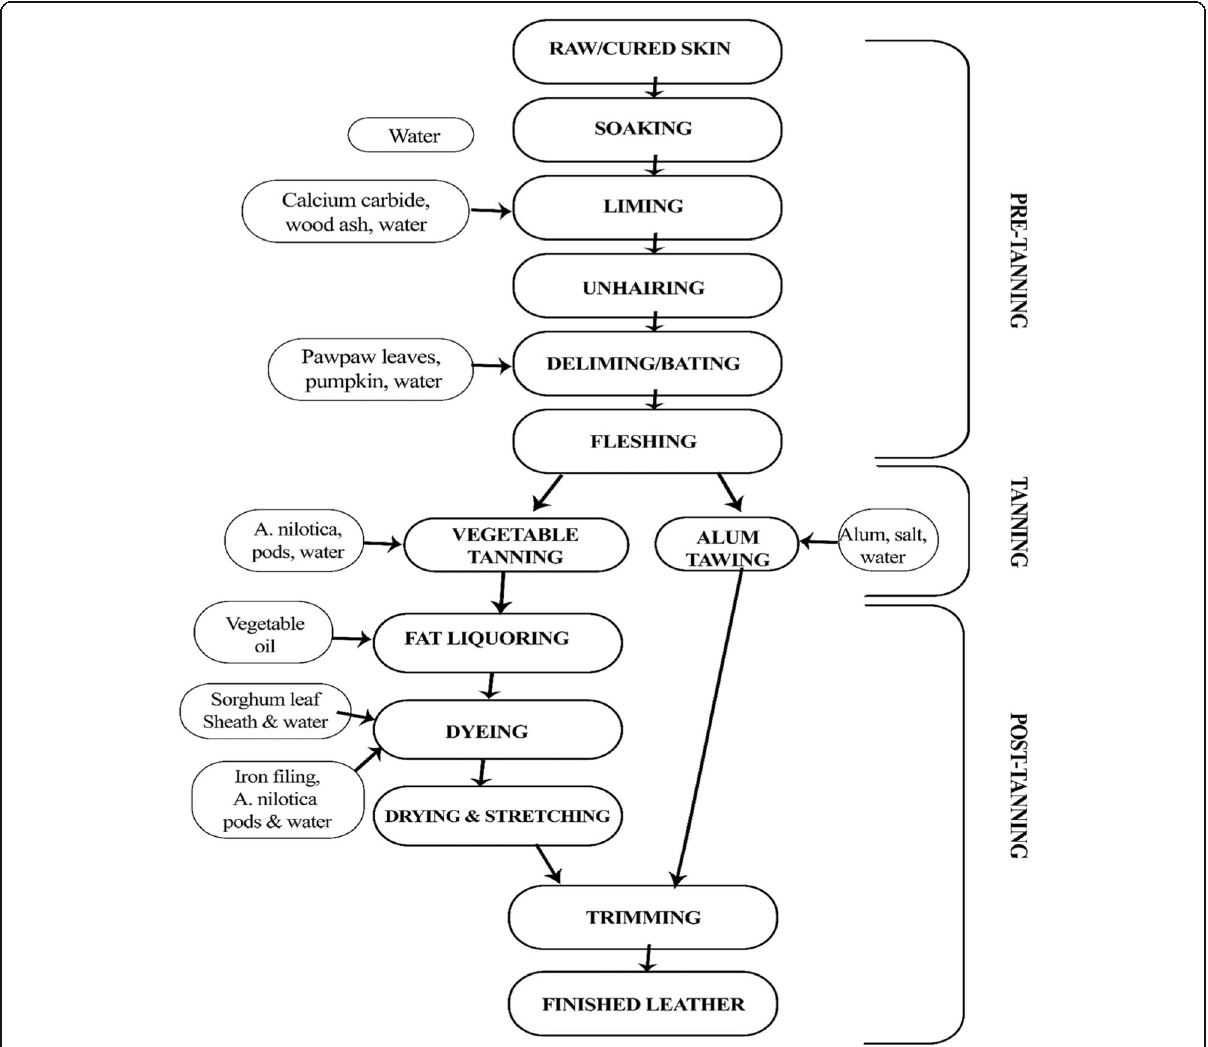
Fig. 2 Schematic diagram of artisanal leather making processes and their corresponding input